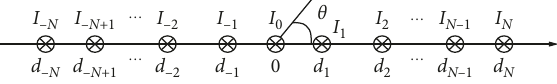
Figure 1: Geometric structure of a sparse linear